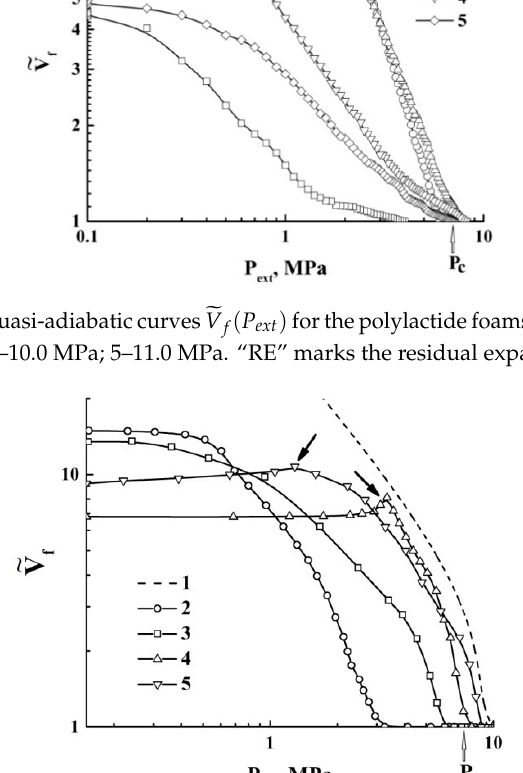
Figure 4. The family of quasi-adiabatic curves   MPa; 2–6.0 MPa; 3–8.0 MPa; 4–10.0 MPa; 5–11.0 MPa. “RE” marks the residual expansion.